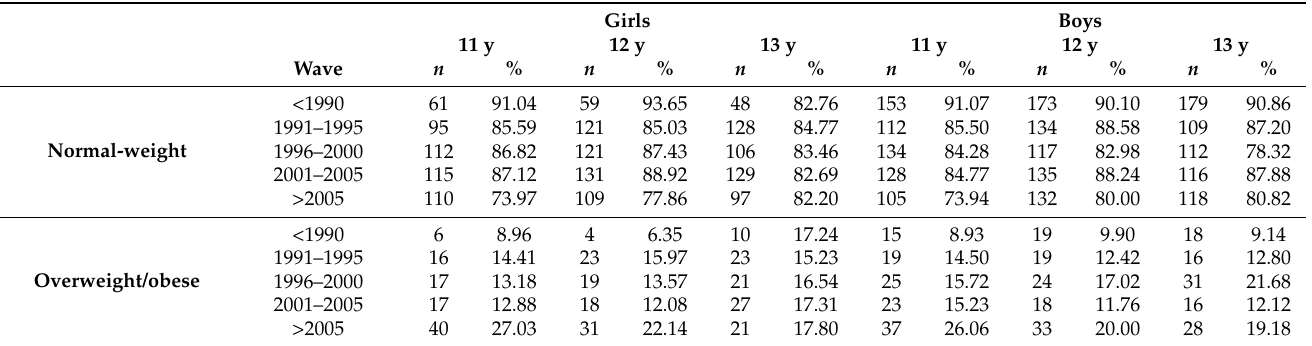
Table 1. Prevalence of normal weight subjects and adolescents with overweight/obesity across years and divided per gender and age.